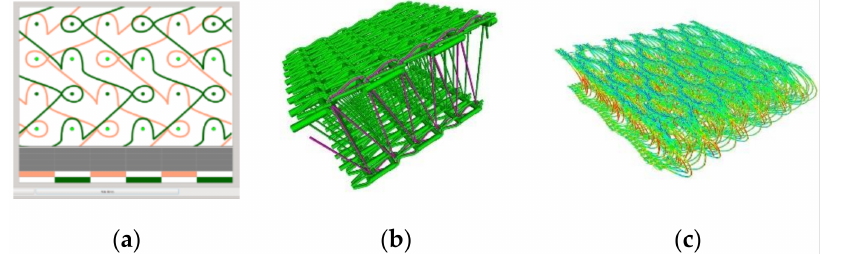
Figure 9. ( a ) Generation of each layer and connector by the TexMath module MeshUp; ( b ) visualiza- tion of the mesh with individual threads; ( c ) simulation of the outer-plane compression of the spacer fabric by the module FiberFEM.